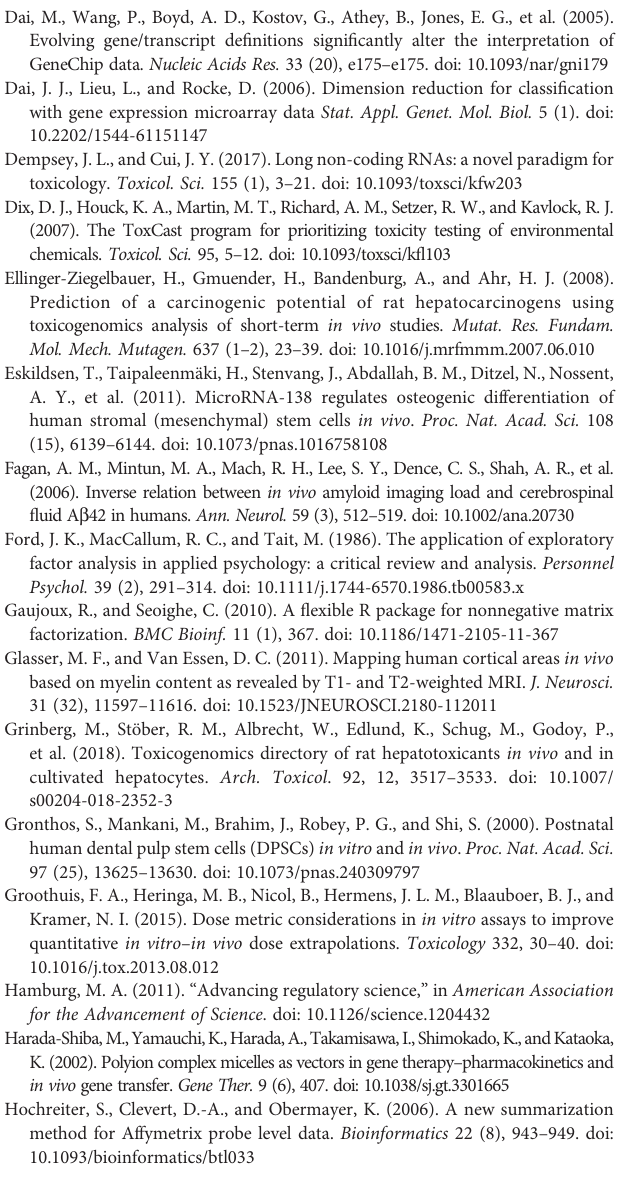
numbers of differentially expressed genes by using Spearman ’ s correlation coef fi cient. TABLE S1 | The list of 119 common